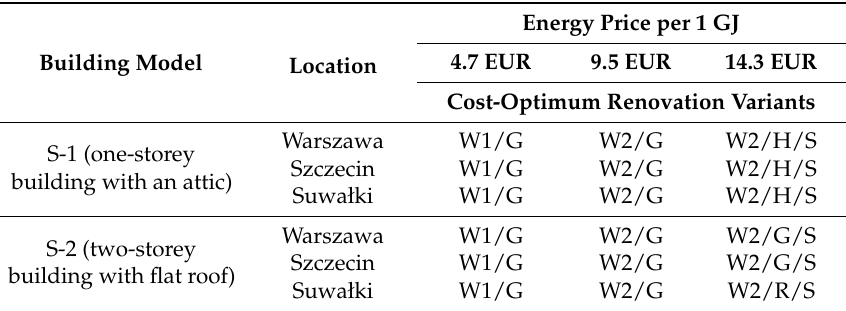
Figure 3. Discounted cumulative cost (K Rd ) for different renovation variants, base case (W0), locations and buildings models S-1 and S-2 in relation to energy need for heating (Q H ). Energy price: 9.5 EUR/GJ. Table 17. Cost-optimum renovation variants.